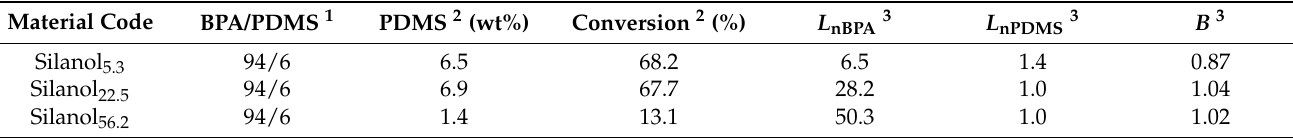
Table 5. Molecular-structure characteristics of PC-PDMS copolymers with different chain lengths of silanol-terminated PDMS obtained from 1 H-NMR and 13